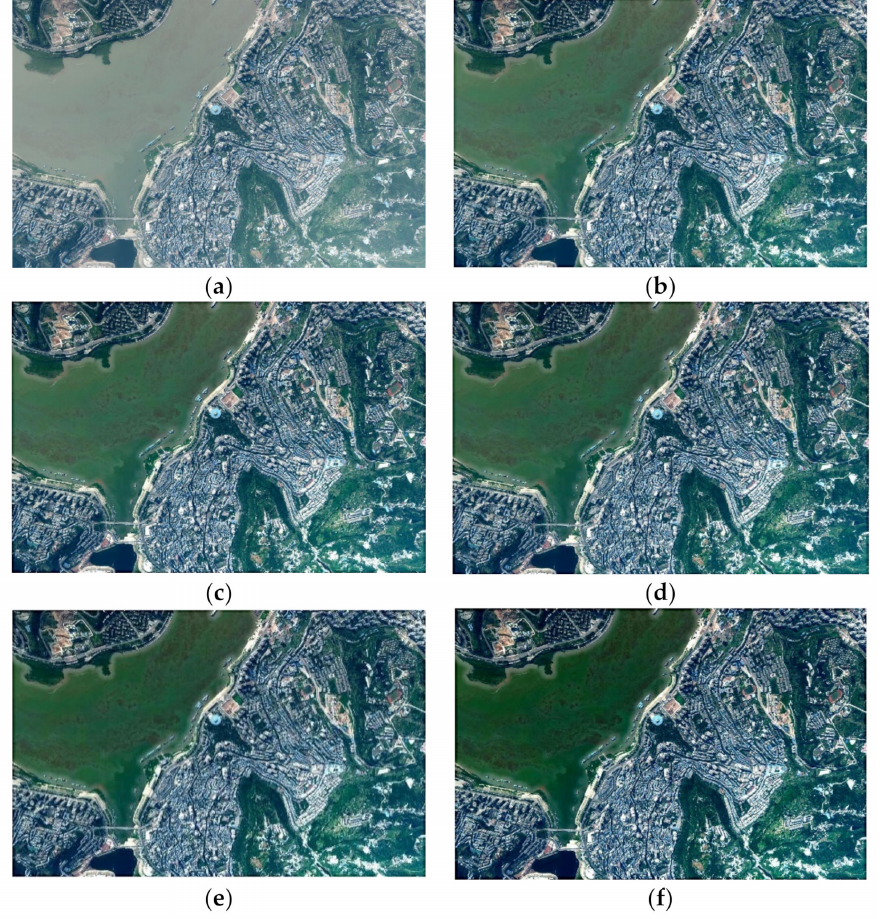
Figure 7. ( a ) Image of foggy coastal countryside; ( b ) ω = 0.65; ( c ) ω = 0.75; ( d ) ω = 0.85; ( e ) ω = 0.95; ( f ) ω =